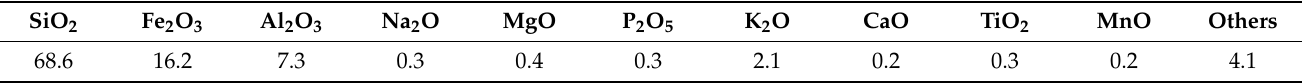
Table 2. Concentrations of rare-earth elements in weathered residual rare-earth ore, as analyzed by